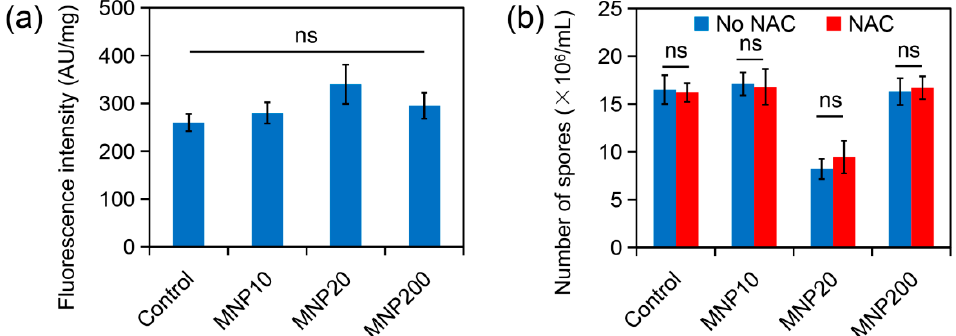
Figure 5. ROS accumulation and its contribution on sporulation of A. niger under MNP treatment. ( a ) ROS levels in MNP-treated A. niger cells revealed by DCFH-DA staining and fluorescence quantification. ( b ) Effect of the ROS scavenger NAC on sporulation of A. niger . Note that the addition of NAC has no obvious impact on sporulation. The letters “ns” indicate no significant difference between the groups ( p < 0.05).